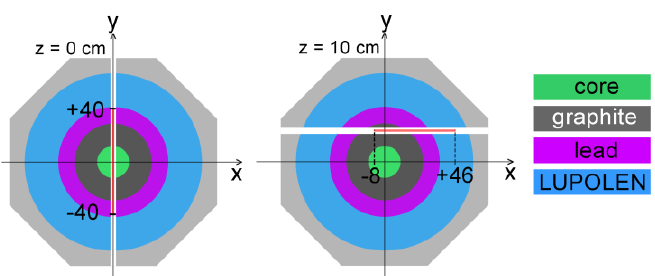
Fig. 4 - Simplified schemes of the profile measurements inside channel I (left) and channel II (right). The red lines indicate the spatial range in which measurements are performed.